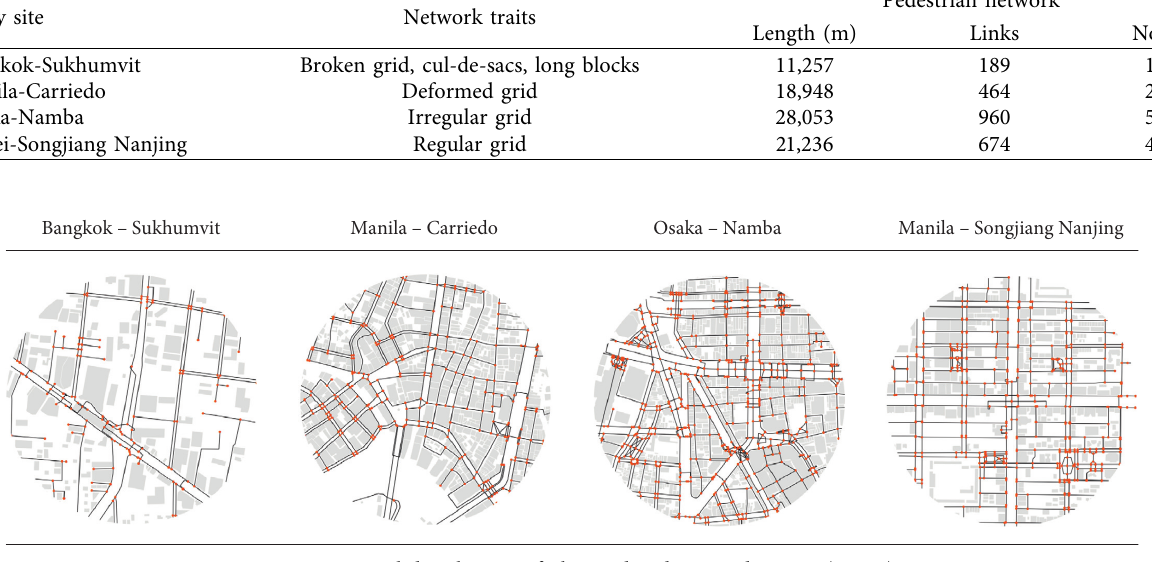
Figure 1: Spatial distribution of observed pedestrian densities (400